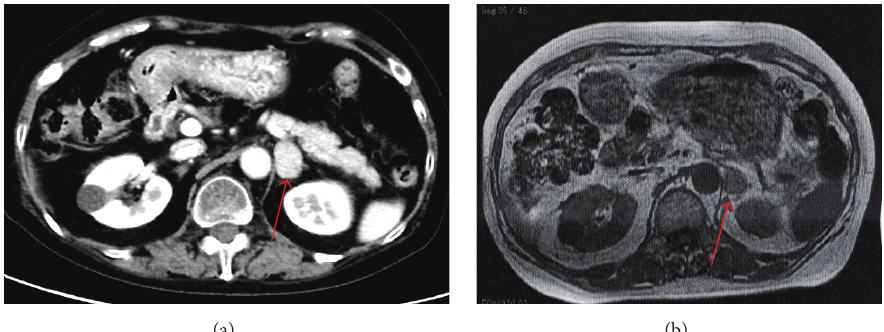
Figure 1: A 62-year-old woman with Cushing’s syndrome: (a) computed tomography and (b) magnetic resonance imaging showed an adrenal tumor (29 × 22 mm, red arrow).